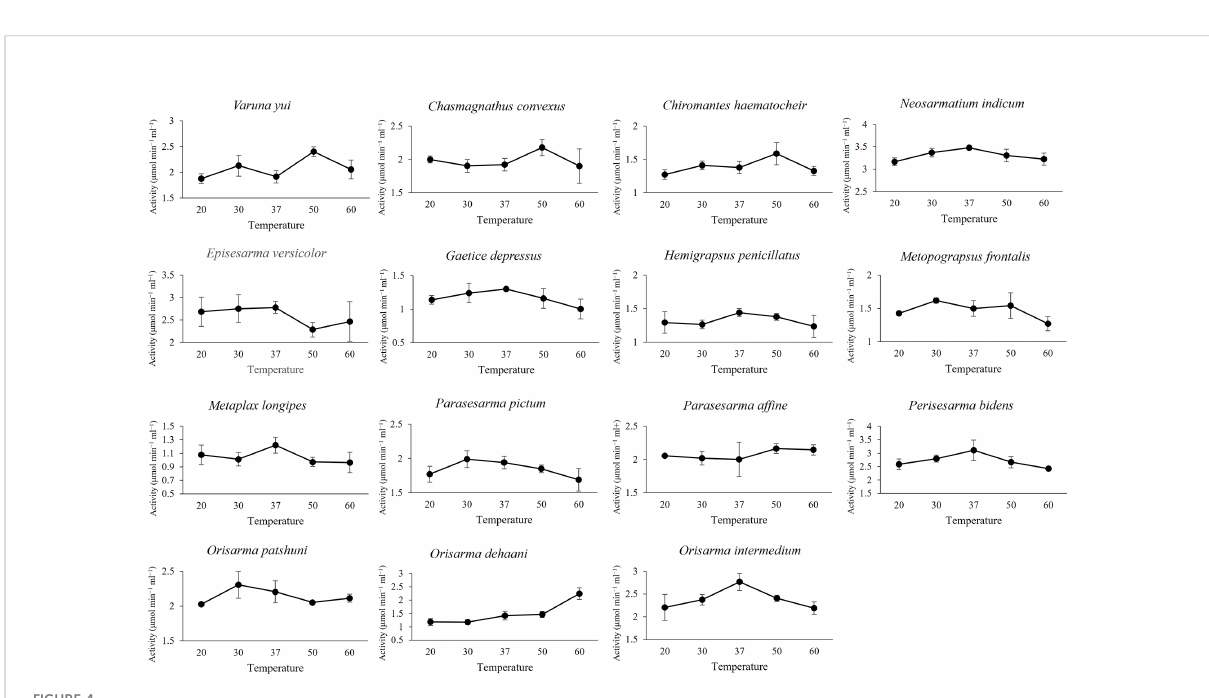
FIGURE 4 Effect of temperature on EG